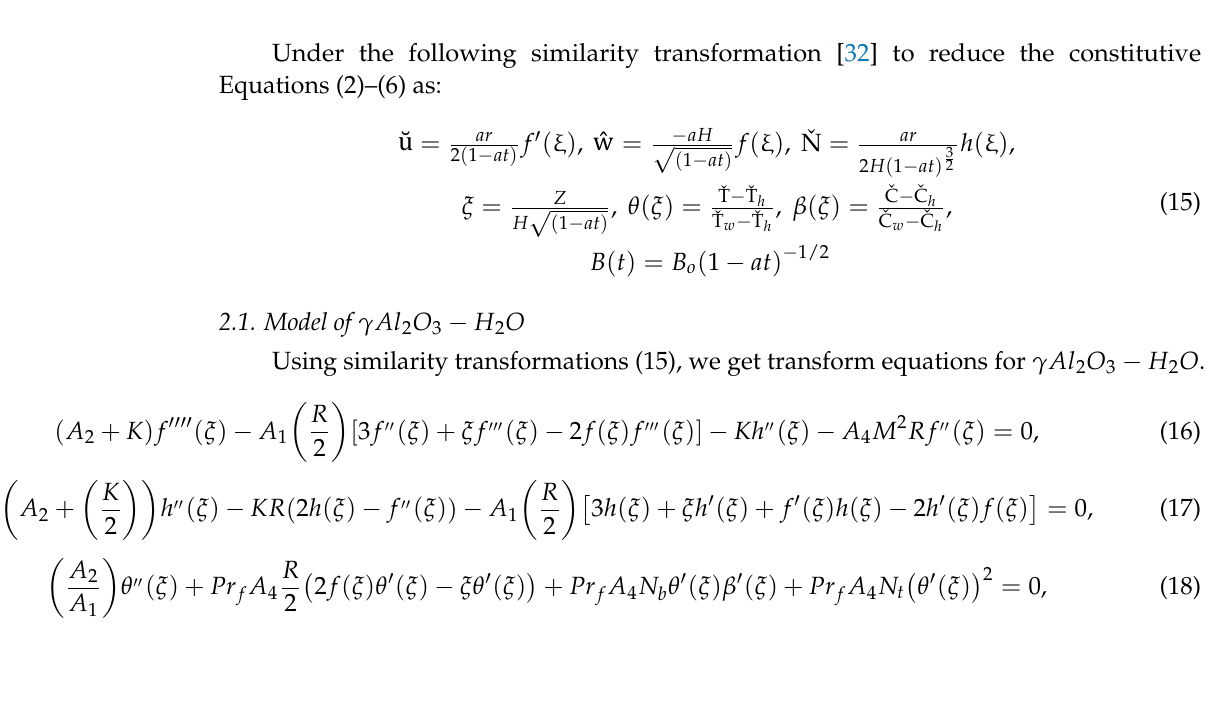
Figure 1. Geometry of the problem .